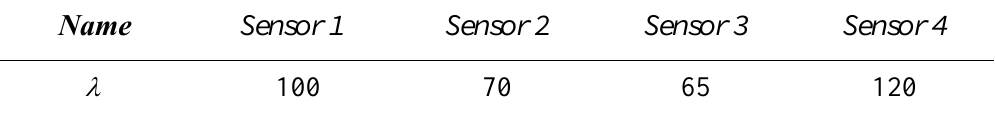
Table 2. The optimal variance ratio factor  for sensors in the e-nose.